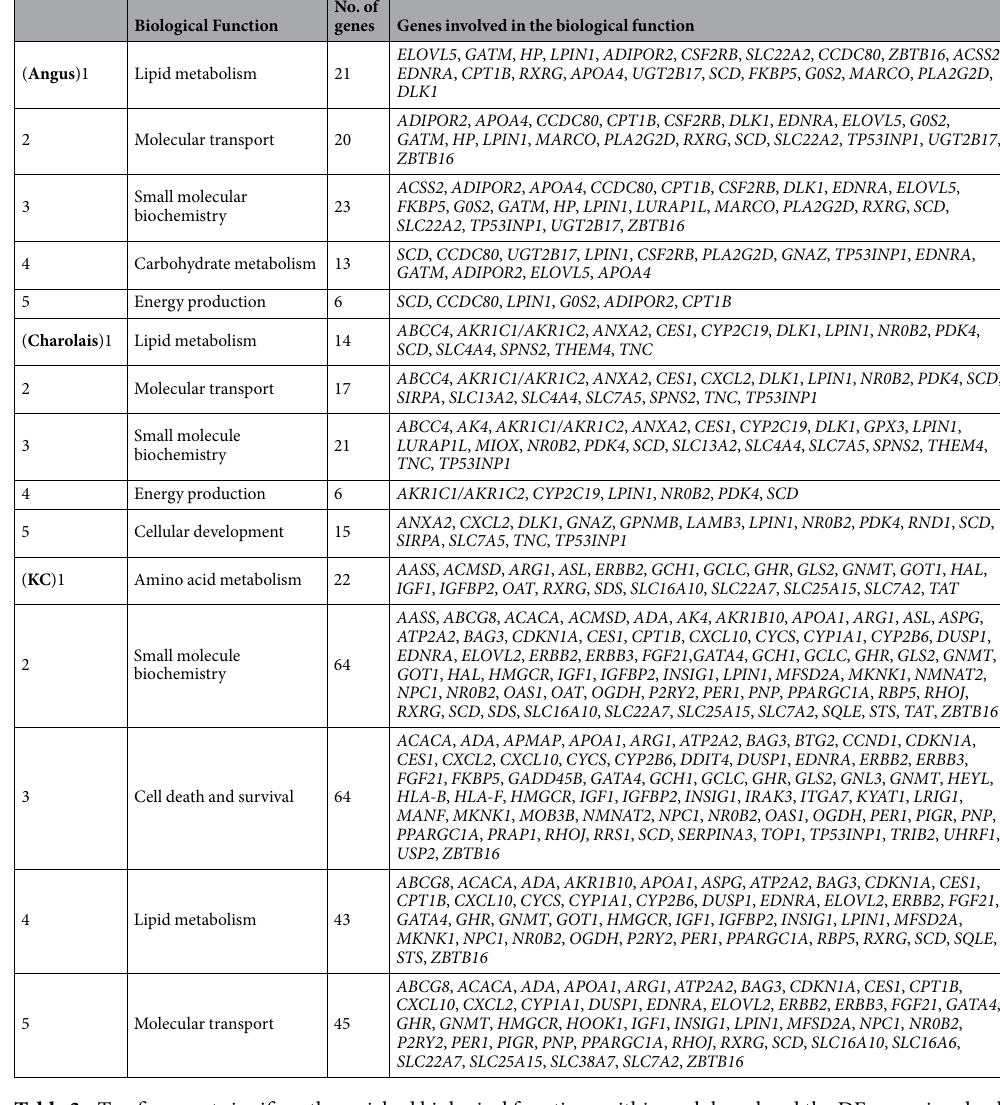
Table 3. Top five most significantly enriched biological functions within each breed and the DE genes involved within each specific